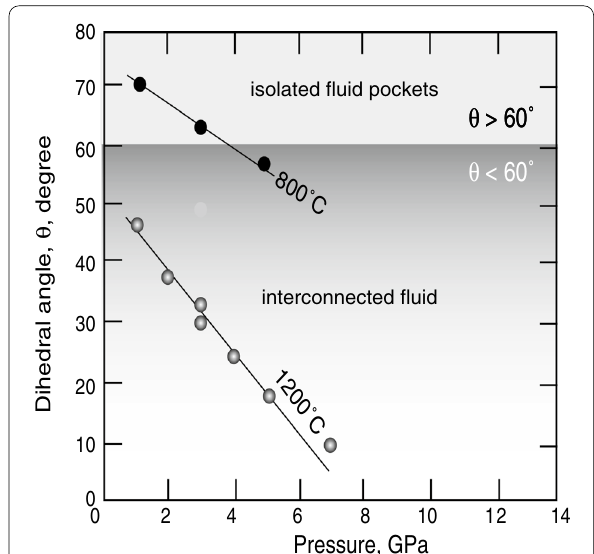
Fig. 39 Dihedral angle of aqueous fluid in the olivine–H 2 O system as a function of pressure at temperatures indicated. Modified from Yoshino et al.